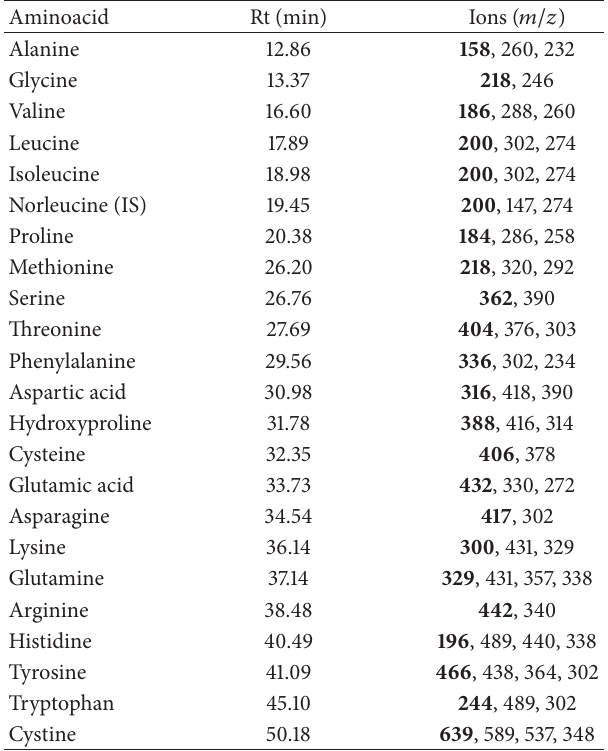
Table 1: Ions selected in SIM mode (quantification ions in bold) and retention time (Rt) for the analysis of free amino